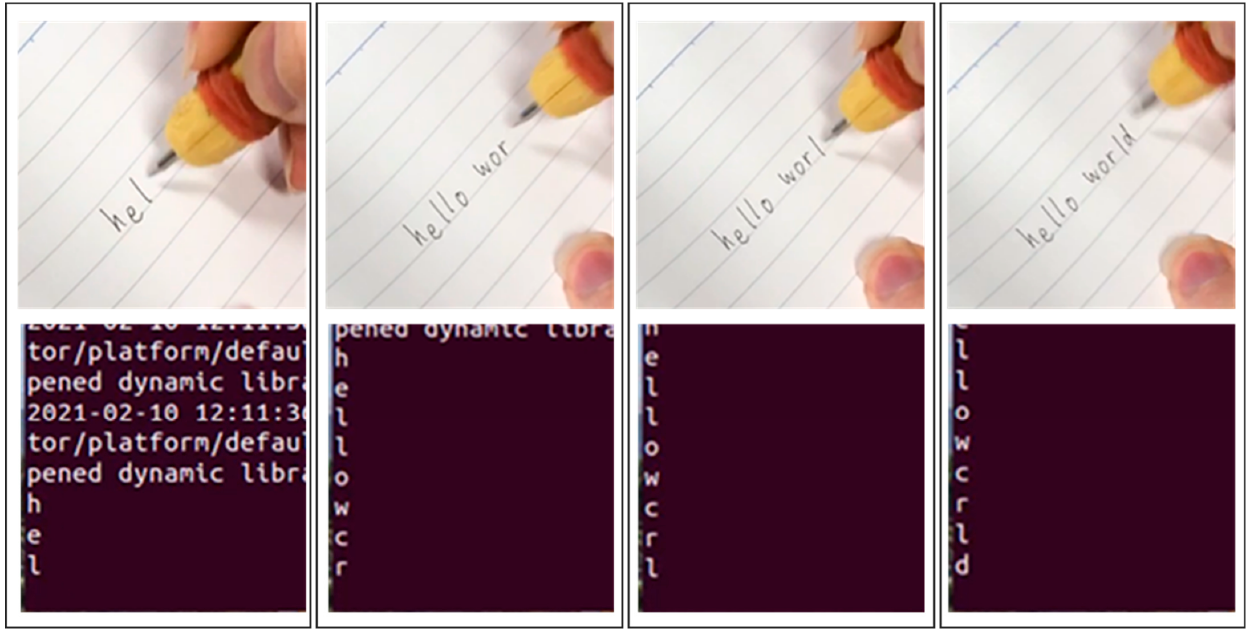
Figure 12. Real-time handwritten character recognition example.